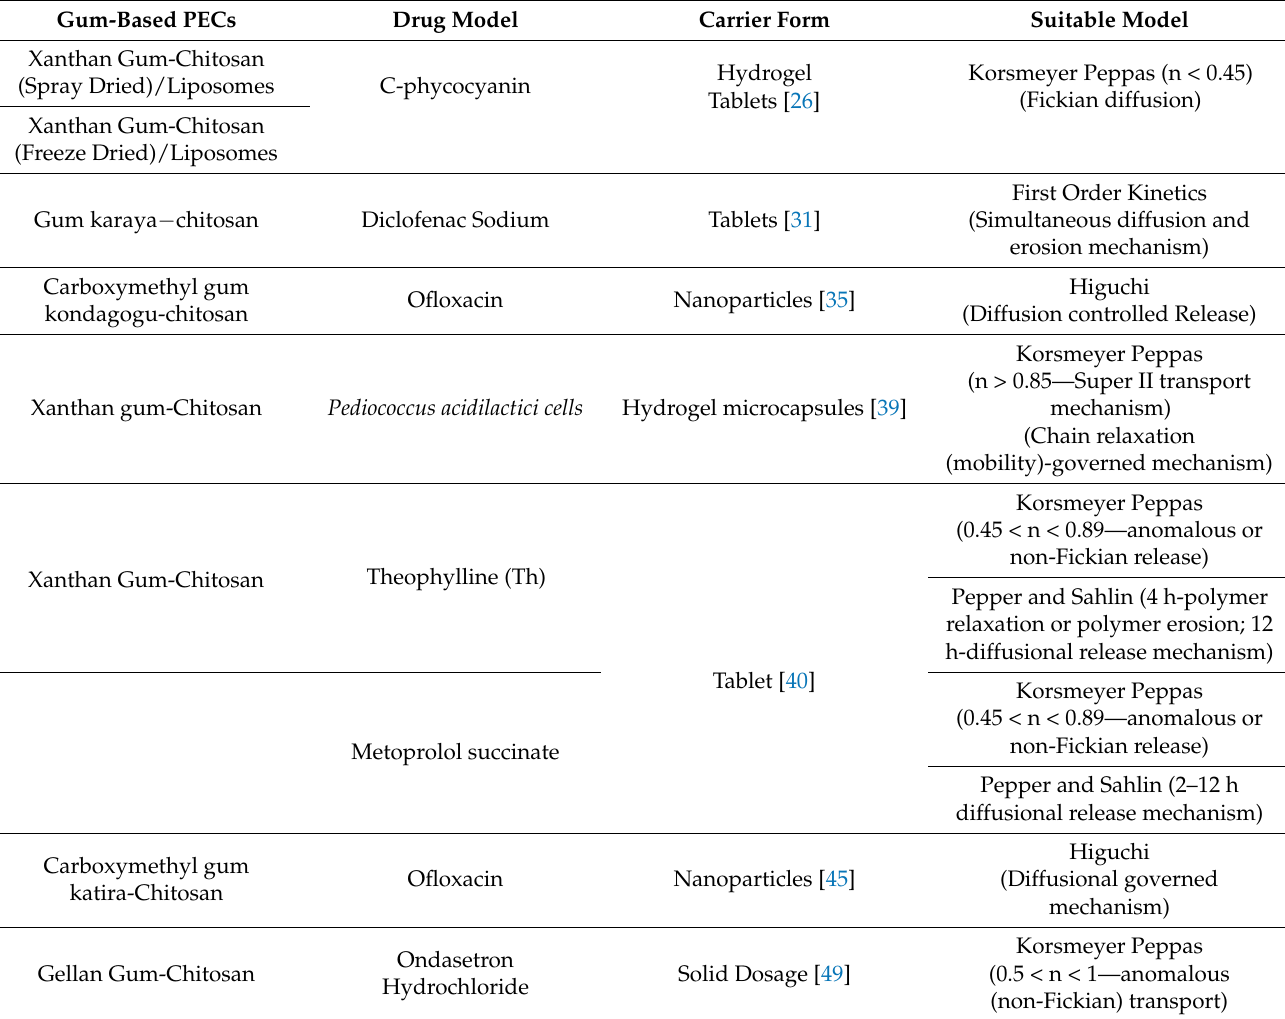
Table 3. Summary of mathematical drug release model gum-based